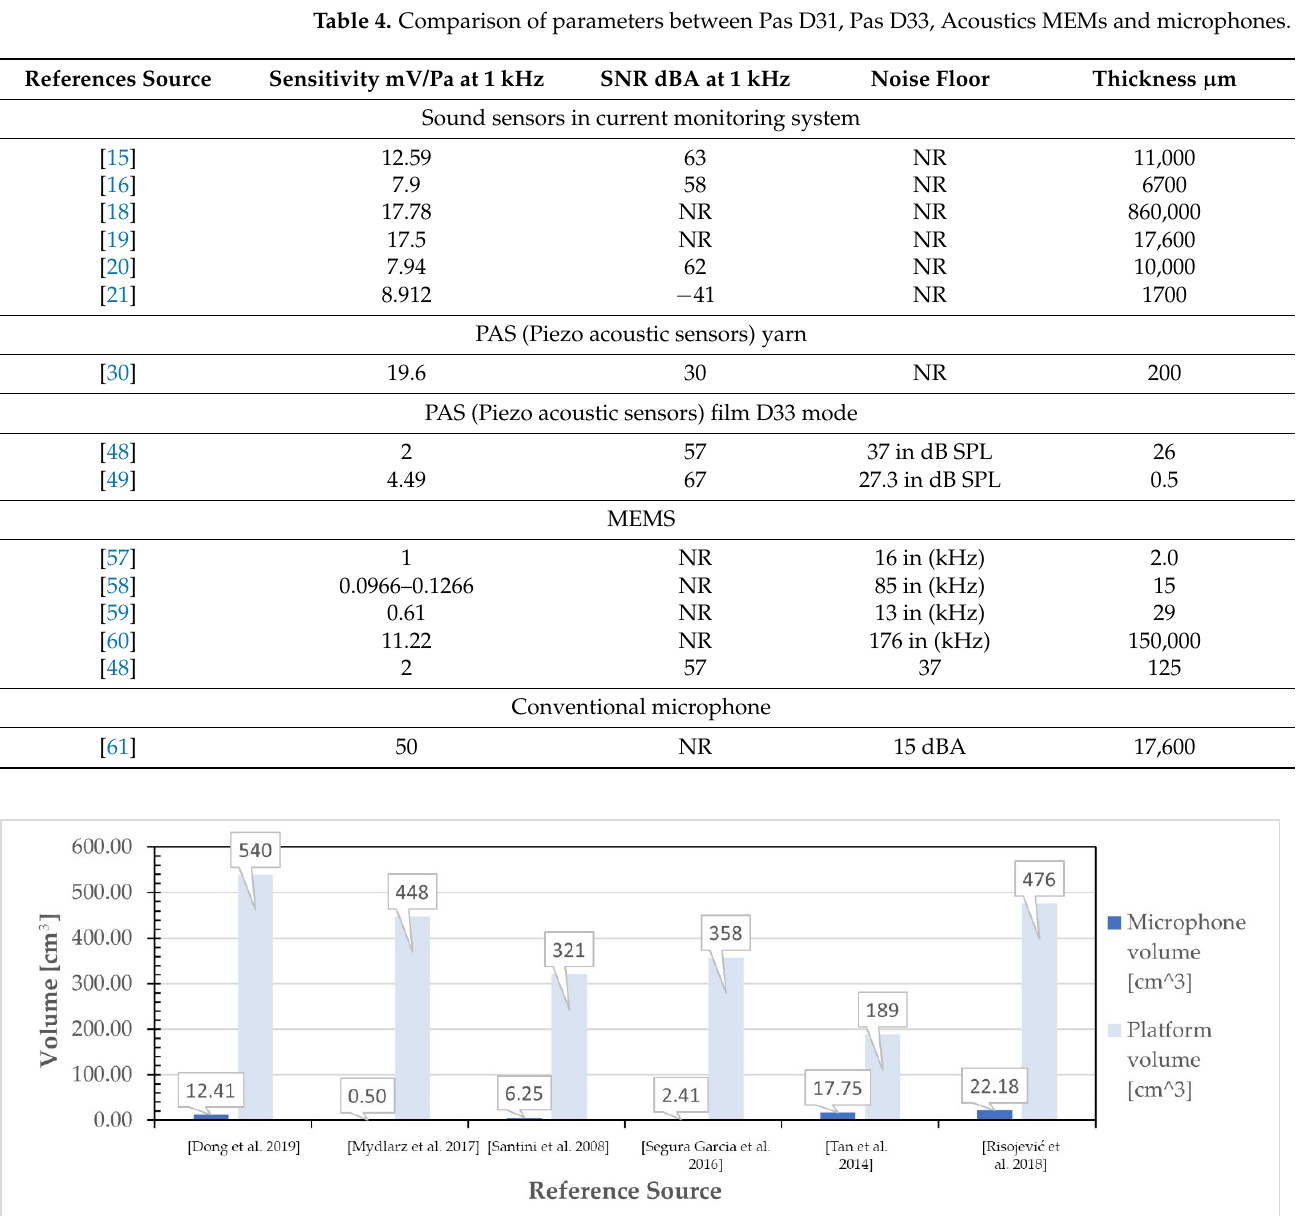
Figure 4. The relations between the volume of the MEMS microphones themselves and with the hardware of the monitoring system. ([Dong et al. 2019] [15], [Mydlarz et al. 2017] [16], [Santini et al. 2008], [18], [Segura Garcia et al. 2016] [19], [Tan et al. 2014] [21], [Risojevi´c et al. 2018]